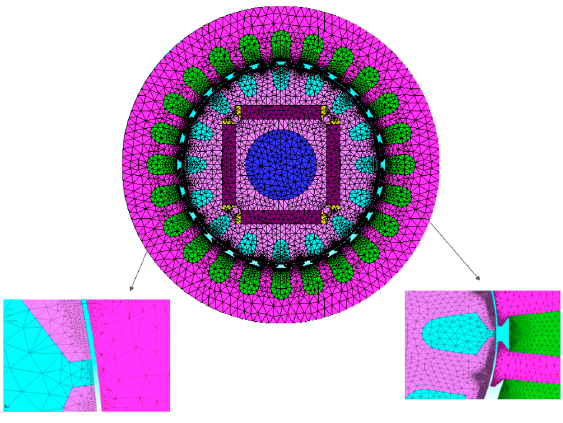
Figure 5. 2 ‐ D mesh model of LSPMS motor. Table 1. LSPMS Motor